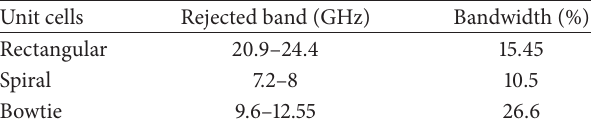
Table 1: Rejected bandwidth for DGS unit